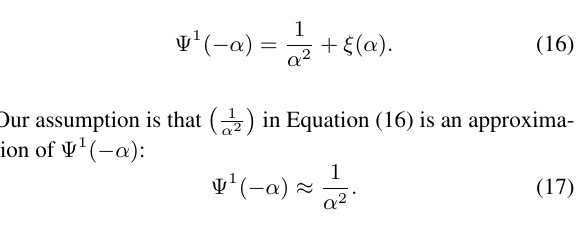
Figure 1. Approximation error.